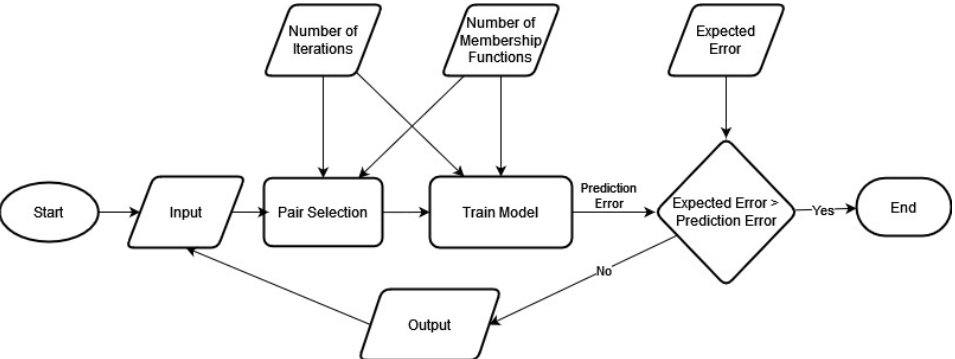
Figure 4. Construction of the Cascaded-ANFIS